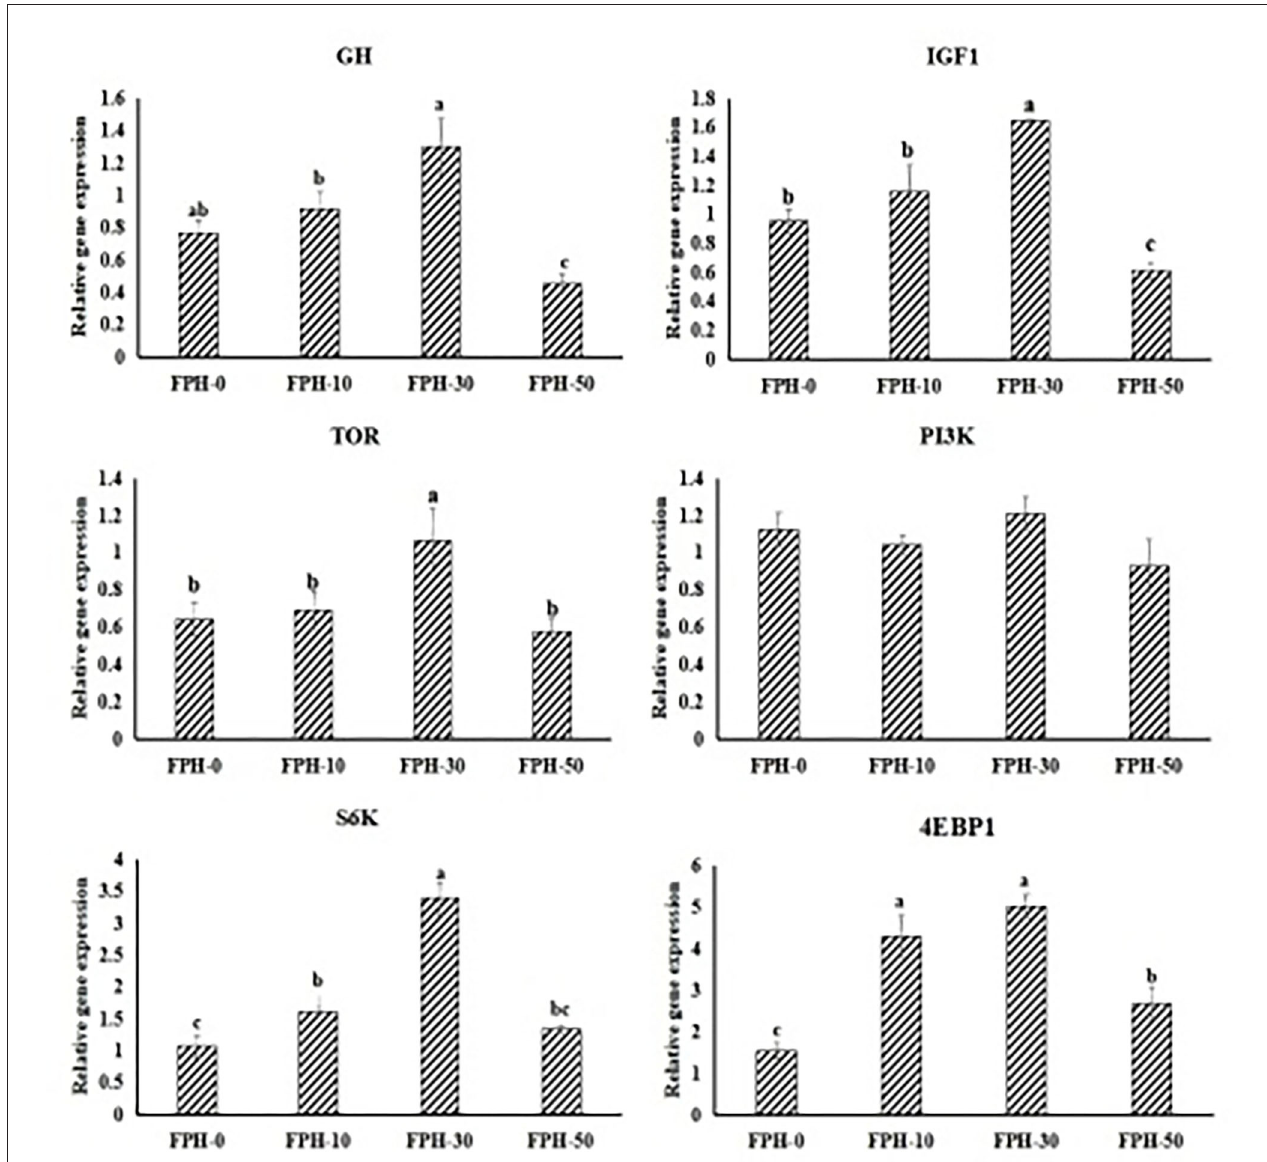
FIGURE 1 | Relative gene expressions of the GH/IGF-1 axis and TOR signal pathway in the hepatopancreas of largemouth bass ( Micropterus salmoides ) fed the diets containing different supplementation levels of fish protein hydrolysate (FPH). Lowercase letters (a, b, c or d) indicate a significant effect of relative gene expressions of the GH/IGF-1 axis and TOR signal pathway in hepatopancreas ( P < 0.05), and the other figures are the same as in this